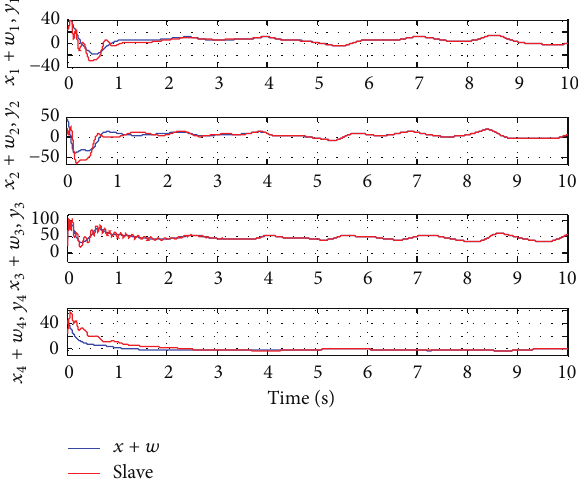
Figure 5: Time histories of the generalized signal (master 𝑥 system plus given function 𝑤 ) and slave system for Case II.